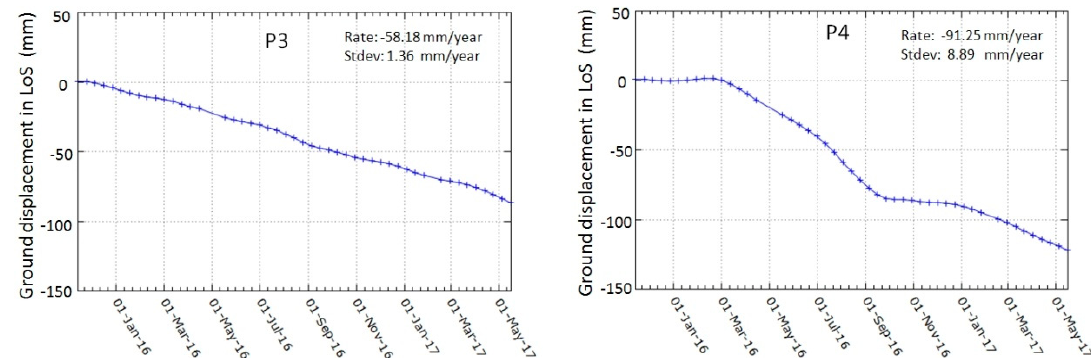
Figure 22. PSI results of the ground displacement in LoS of the points P3 and P4 in the auxiliary dike and reservoir of Baía 3, respectively.